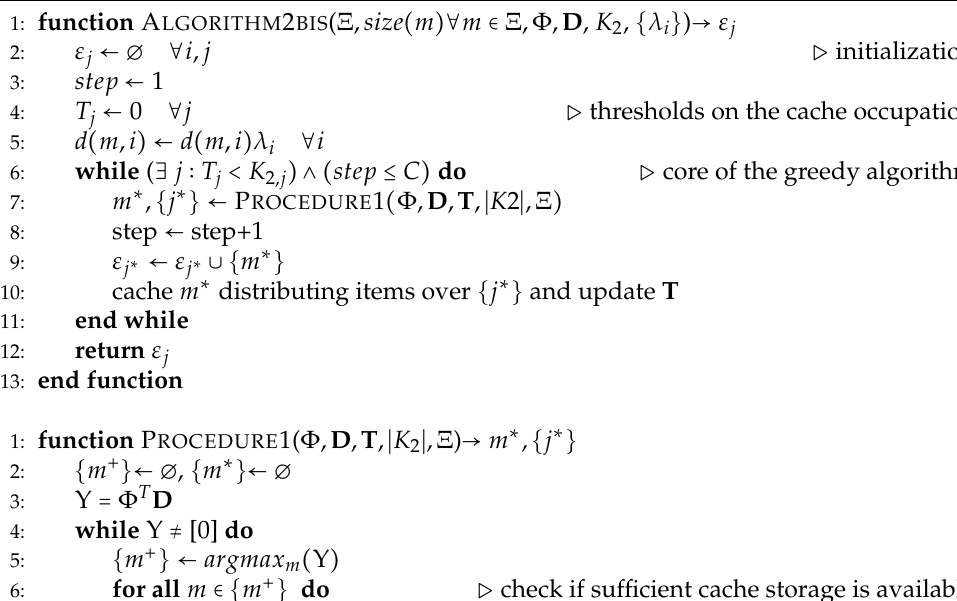
Code 3 Solution to Problem